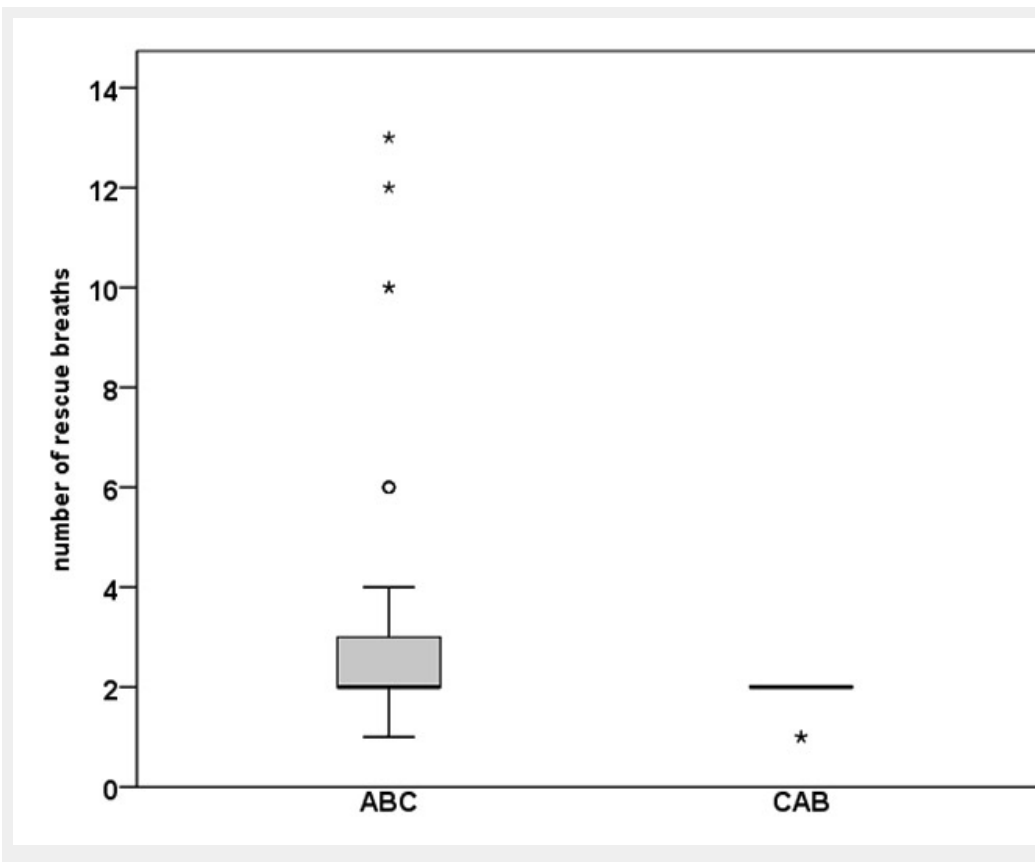
Figure 5 Box and whisker plot displaying the number of rescue breaths applied in the initial cycle consisting of 30 compressions and 2 ventilations. Teams were randomized to use either ABC or CAB as initial approach to CPR. Groups differ significantly (P = 0.006; chi-square test). * = one group; º = 3